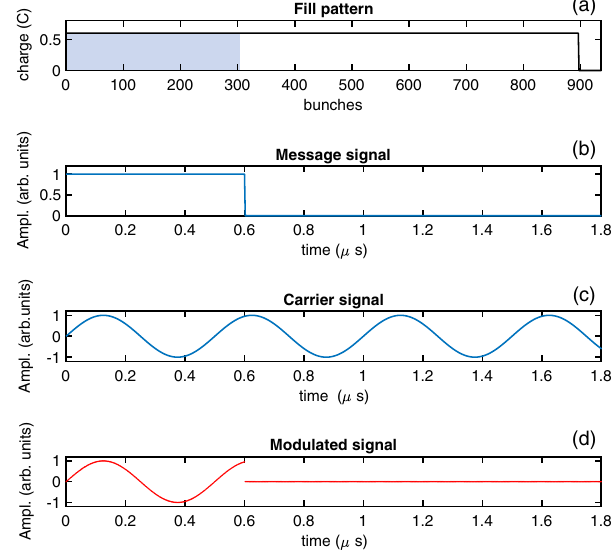
FIG. 3. The excitation regime for the online measurements includes a sinusoidal signal in frequencies according to the spin tune (c) and a rectangular waveform which modulates the signal (b). The modulated signal (d) excites only one part of the fill pattern (colored light blue), leaving the rest unaffected.